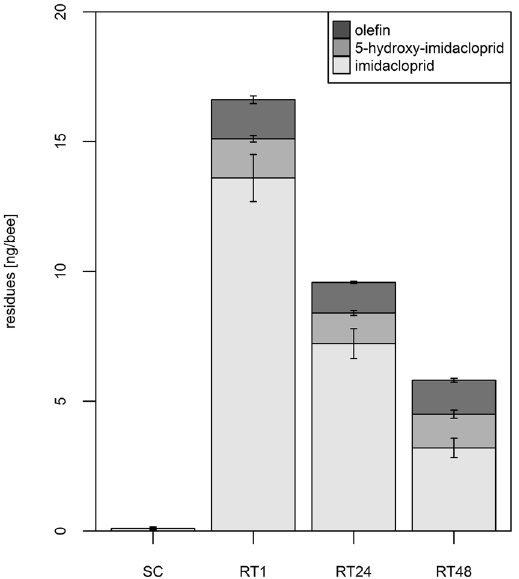
Figure 1. Whole-body imidacloprid residues decrease in honeybee samples over time. Individual honeybees were fed with a sugar syrup control (SC), containing only the solvent acetone but no imidacloprid or a dosage of 41 ng/bee imidacloprid (n = 150 bees/group). The honeybees were frozen after one hour (SC and RT1), 24 hours (RT24), or 48 hours (RT48) at room temperature. LC/MS/MS was used to quantify residue levels of imidacloprid, 5-hydroxy-imidacloprid, and imidacloprid-olefin. Error bars indicate standard error. The imidacloprid residue level was only significantly influenced (p < 0.001) by the time passed after ingestion. The residue level of 5-hydroxy-imidacloprid was influenced by the hive the bees originated from, the time passed after ingestion and interaction effects between both (all p < 0.001). The residue level of imidacloprid-olefin was only influenced by the interaction effects between the hive the bees originated and the time passed after ingestion (p < 0.001, see statistical report in